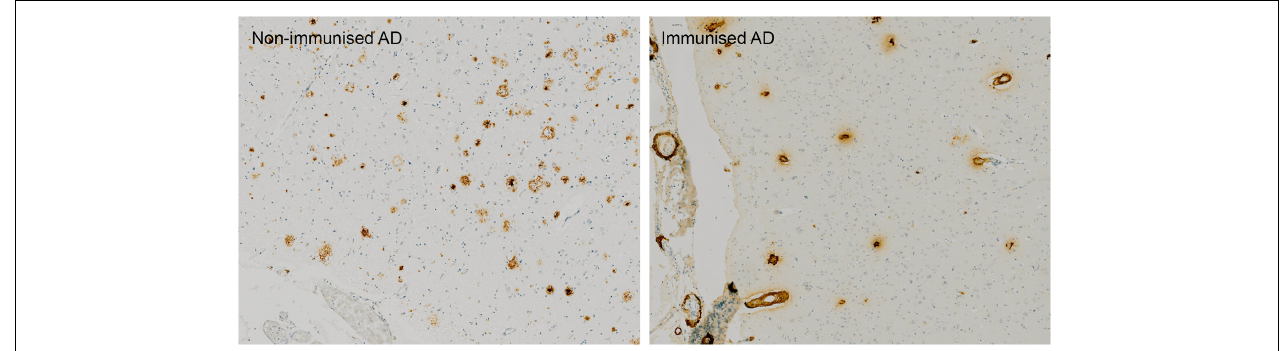
FIGURE 1 | Absence of A β plaques and persistence of vascular CAA in the parietal neocortex of AN1792 immunised case compared to unimmunised control.